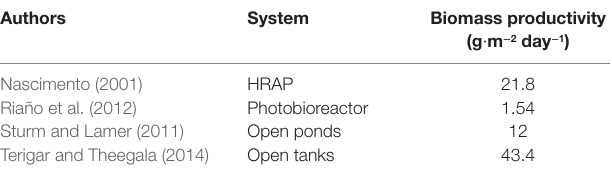
FigUre 2 | Pyrolysis reactor .